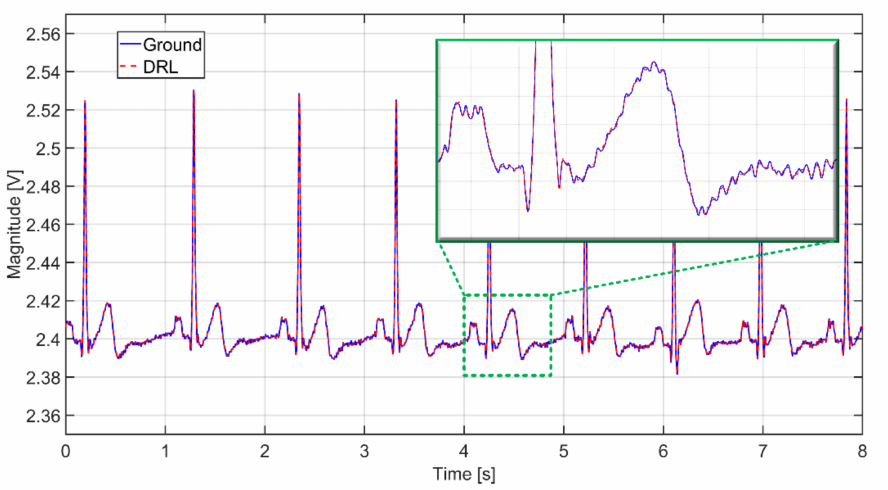
Figure 15. The output signals from simulation while using the same coupling capacitances ( C e1 = C e2 = 150 pF) at the input in two scenarios: The NSE connected to the ground (solid blue), and NSE connected to the output of DRL (dashed